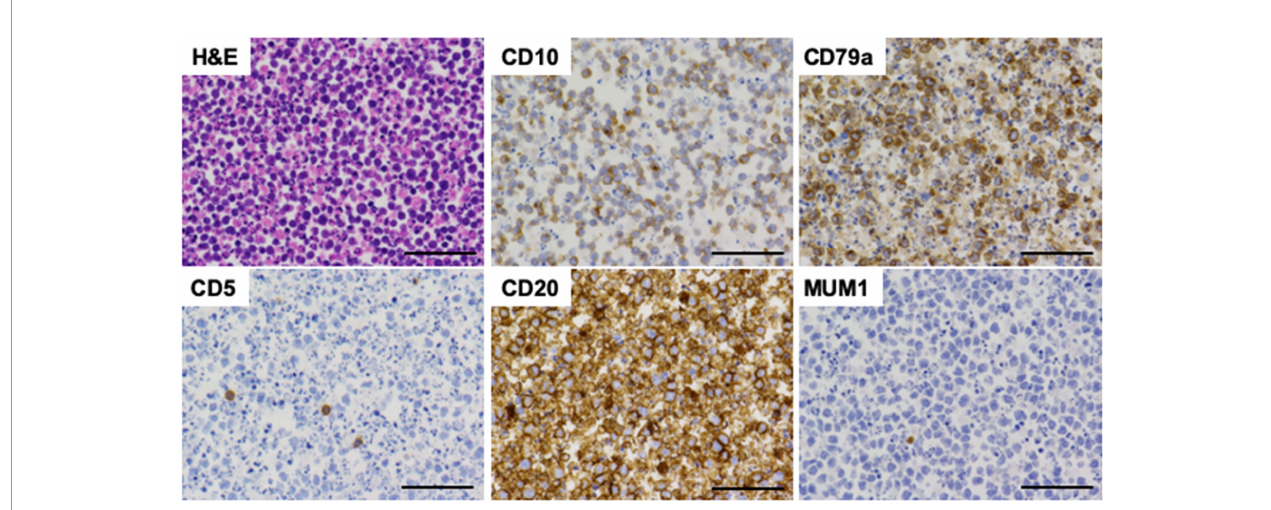
FIGURE 3 | Pathological fi ndingsofascitic fl uidcellblocksamples.Ascitic fl uidcellblocksamplesweresubjectedtohematoxylinandeosin(H&E)stainingand immunohistochemicalanalyses.NeoplasticlymphocyteswerepositiveforCD10,CD20,andCD79awhereasthosewerenegativeforCD5andMUM1.Scalebar,50 m